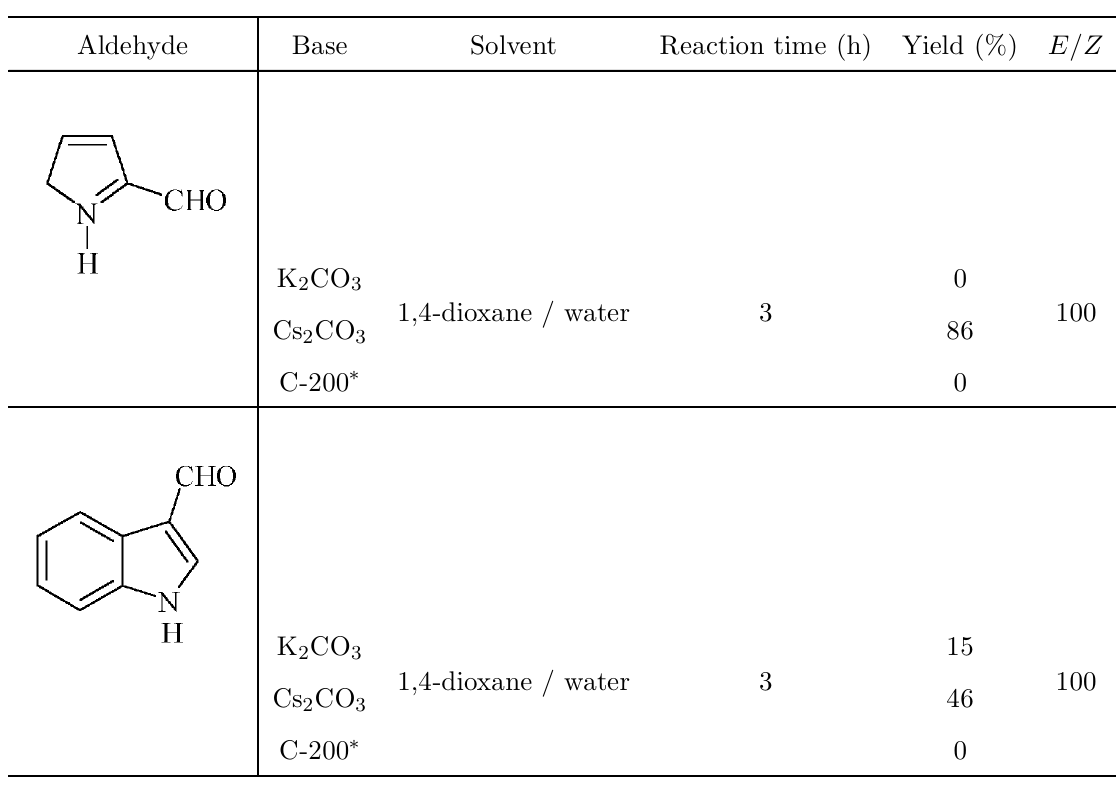
Table 5 The in®uence of the PT catalyst on